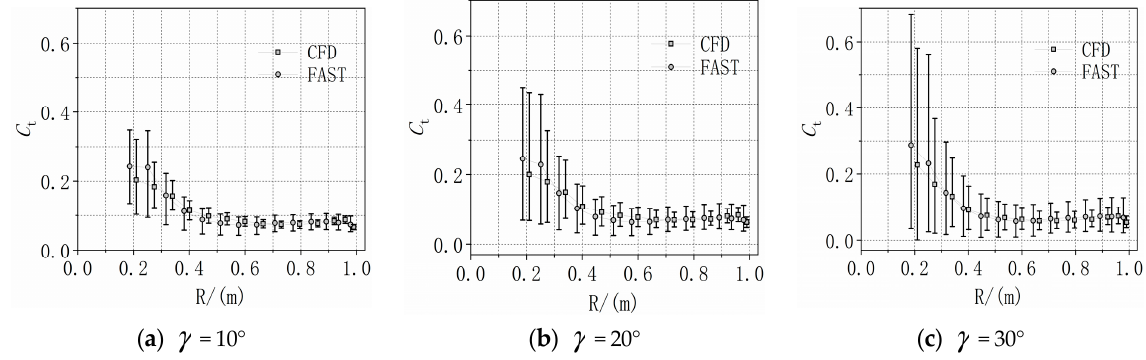
Figure 11. The profile of C t along the blade span under yawed cases.